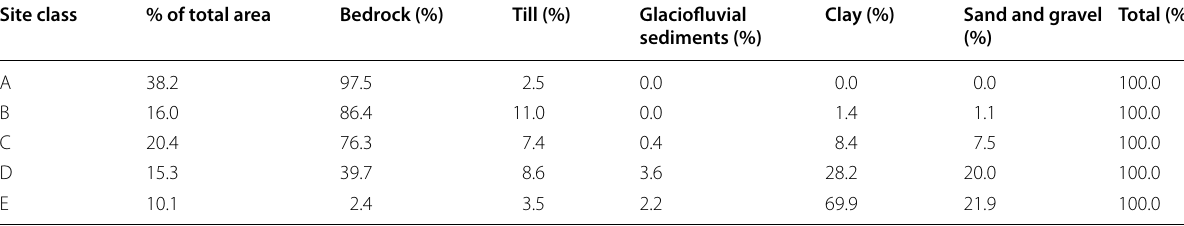
Table 6 Contribution of the different geologic units to the NBCC site classes Site class